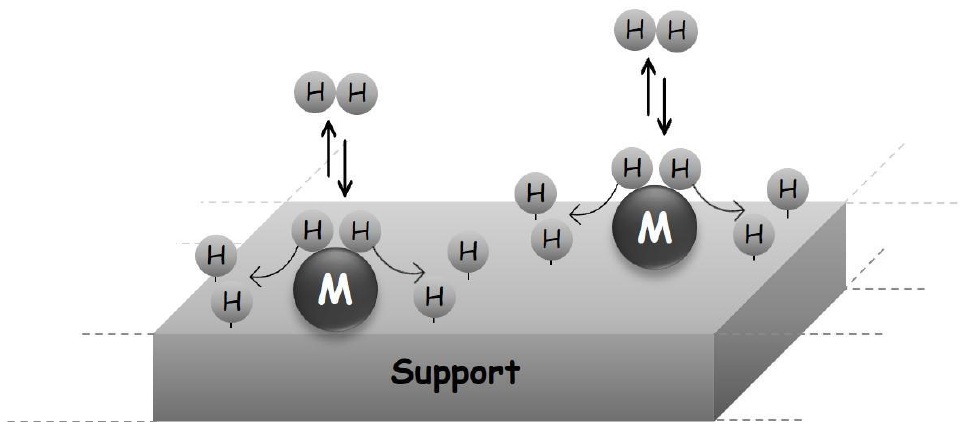
Figure 3. Schematic representation of spillover mechanism.